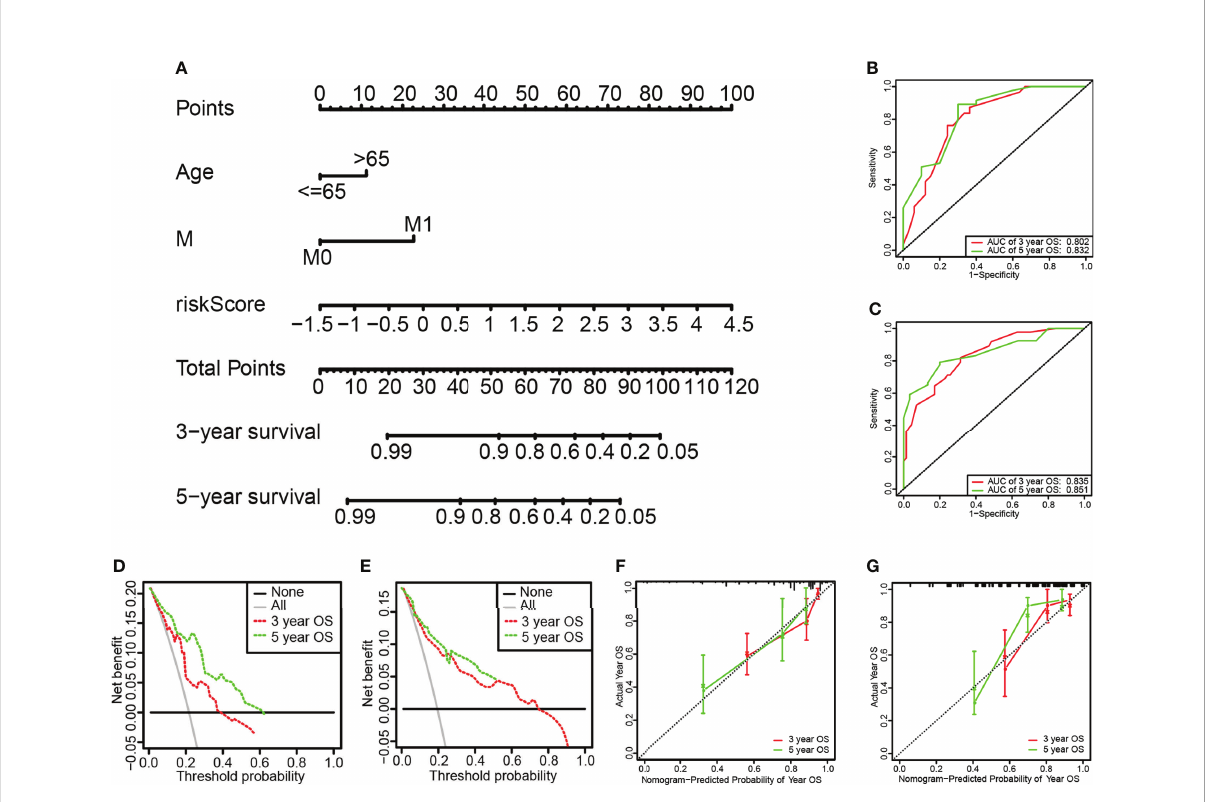
FIGURE 6 Construction and assessment of the Nomogram. (A) The nomogram for predicting the 3-year and 5-year survival rate of the training set and the validation set. (B, C) ROC curve of the training set and validation set. The AUC values of the 3-year and 5-year survival rates of the training set were 0.802 and 0.832, respectively. The AUC values of the 3-year and 5-year survival rates of the validation set were 0.835 and 0.851, respectively. (D, E) Calibration chart nomogram of the training set and validation set. (F, G) DCA clinical decision curve of training set and validation